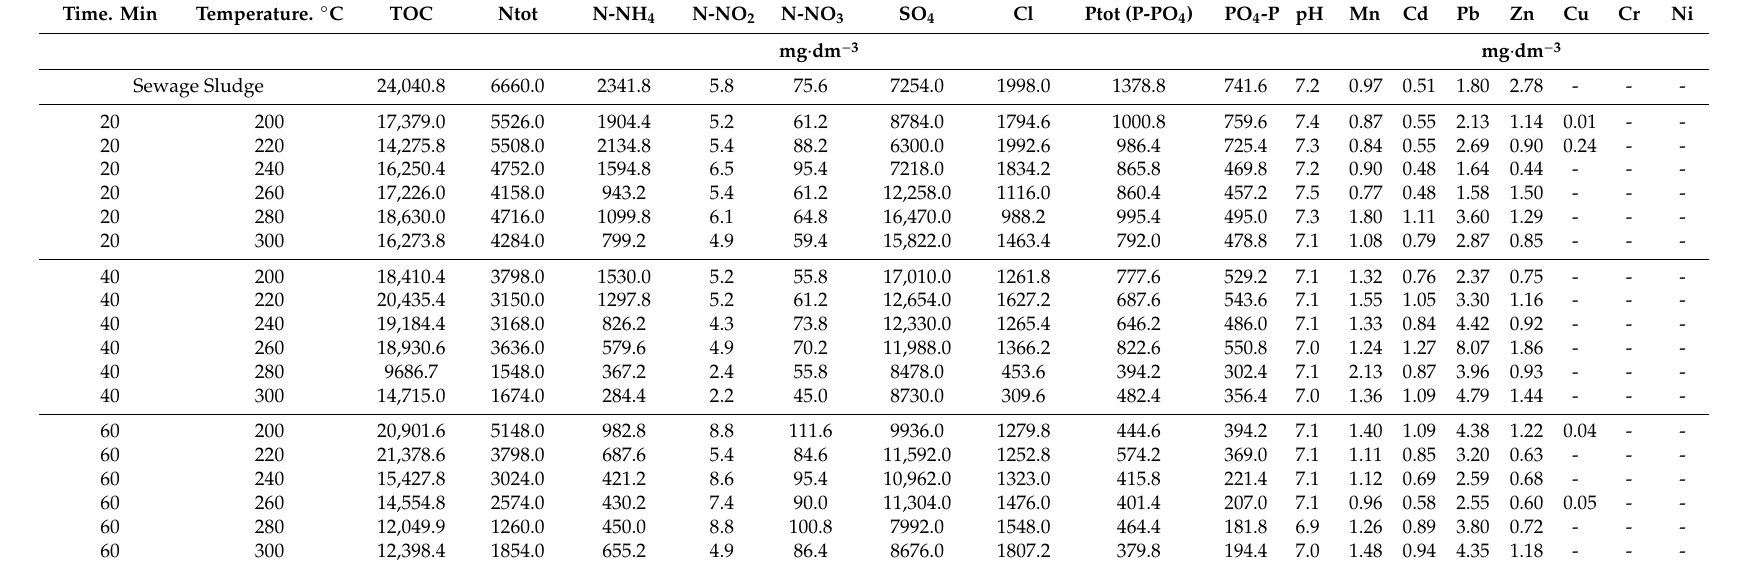
Table 4. Mean values of contaminants’ concentrations and pH values from water extracts of raw sewage sludge and torrefied SS obtained from torrefaction of sewage sludge in 6 temperature variants, with three retention